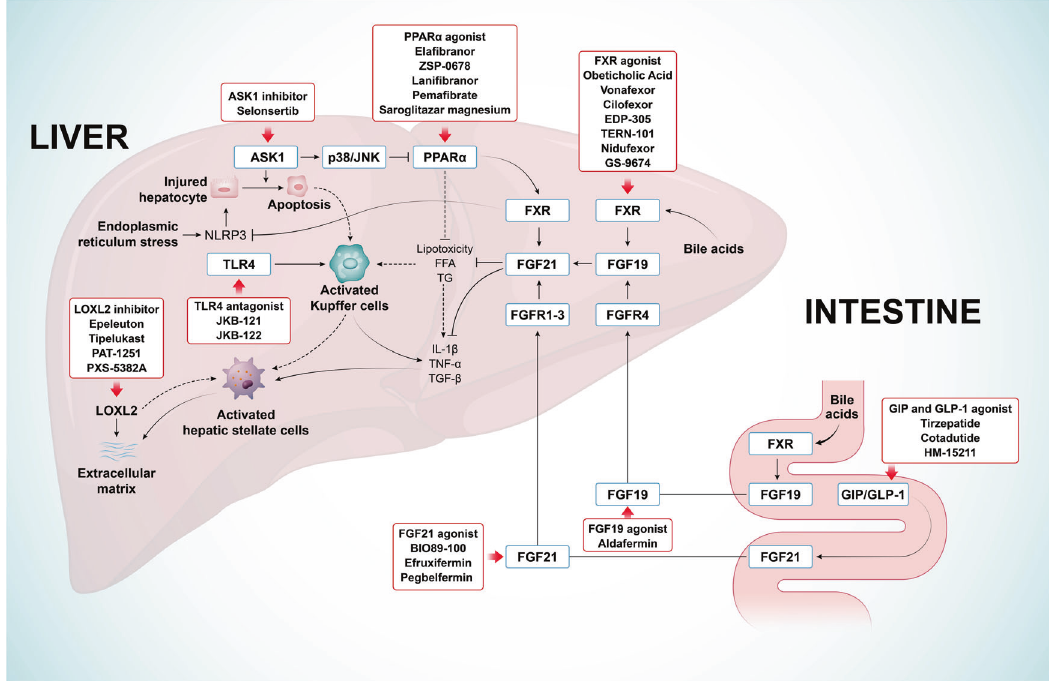
Fig. 6 Molecular signaling pathways of NASH and a summary of related target drugs. FFA, free fatty acid; TG,